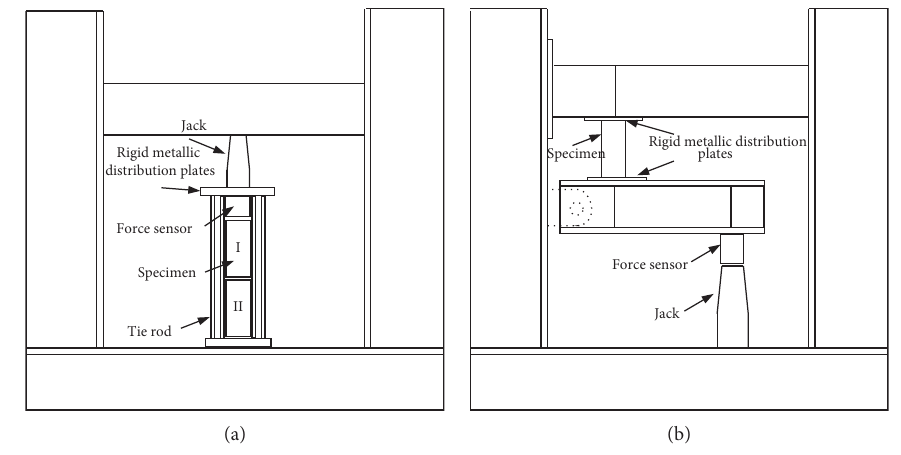
Figure 5: Creep test apparatus: (a) conducted by Fu [6] and (b) Lin [25]. Table 5: Material constants for the B4 creep model (10 − 6 /MPa).